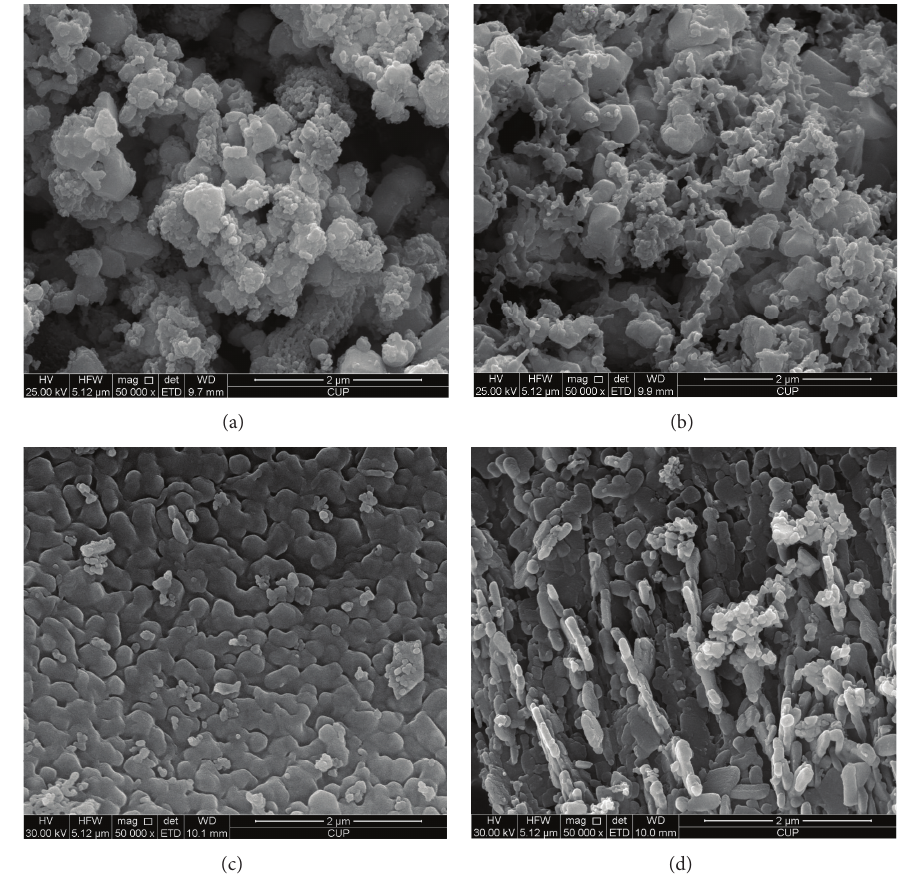
Figure 6: SEM images of iron nitride samples. (a) FN-1, (b) FN-2, (c) FN-3, and (d) FN-4.